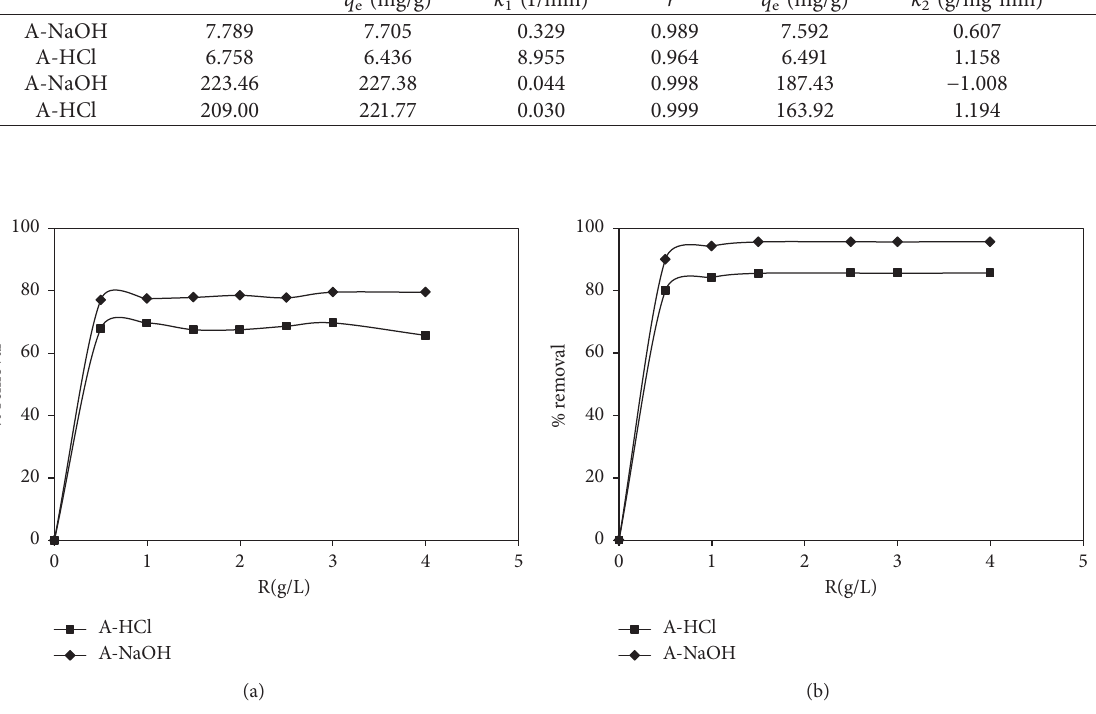
Figure 6: Percentage removal of BB (a) and MB (b) as a function of the mass of treated acacia sawdust: A-NaOH and A-HCl.